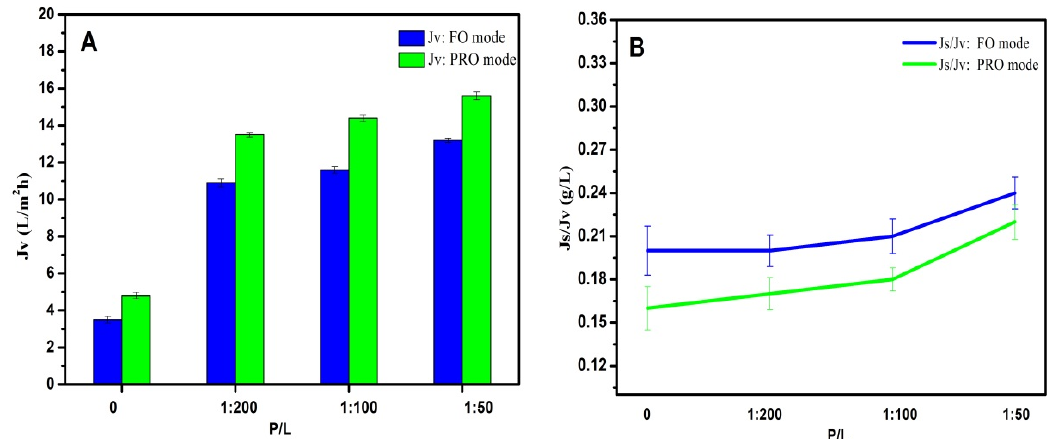
Figure 6. FO performances of double-skinned membranes by using 2 mol/L MgCl 2 as the DS and DI water as the FS. ( A ) J v of double-skinned membranes; ( B ) J s / J v of double-skinned